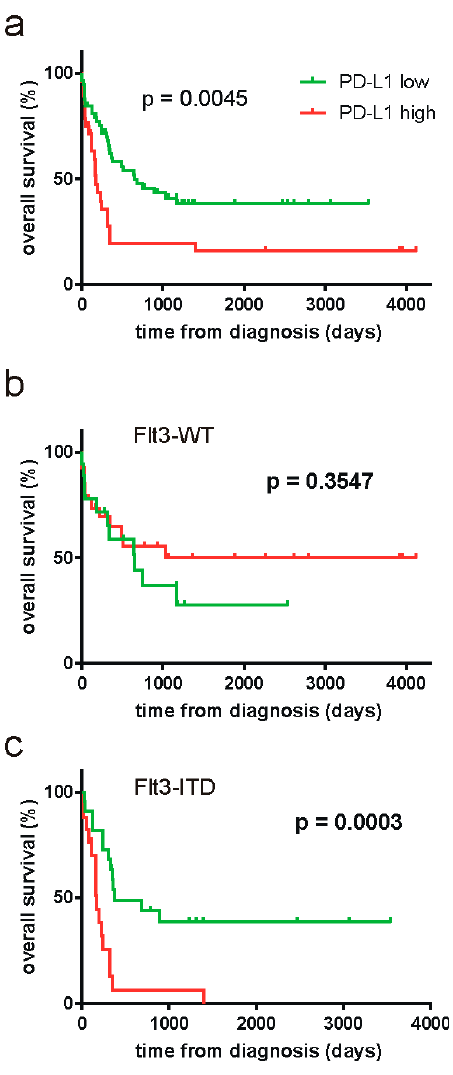
Figure 3. Survival curves for AML patient groups according to PD-L1 levels. The whole cohort ( a ) or the subcohorts containing patients with wild-type FLT3 ( b ) or with FLT3-ITD ( c ) were divided according to v1 / v2 PD-L1 cDNA and the corresponding survival curves were compared using the Mantel–Cox t -test. The reached p-values are given in the plots.